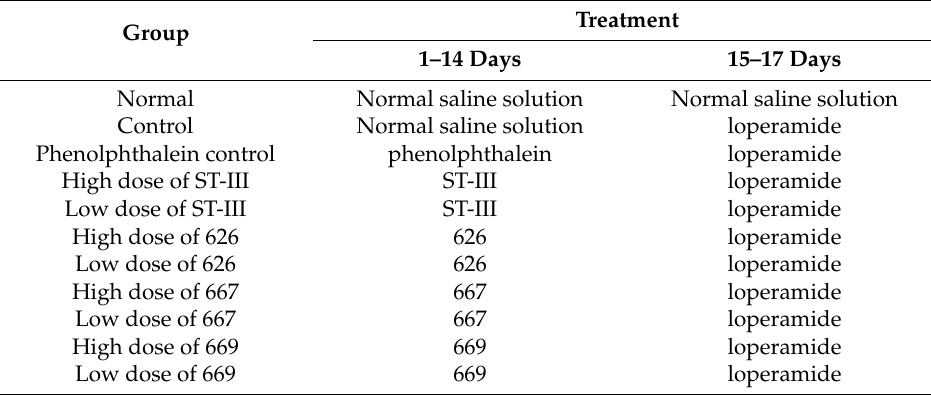
Table 6. Specifics of the animal